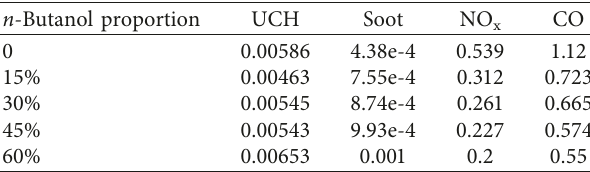
Table 6: The final content of UCH, soot, NO, and CO. n -Butanol